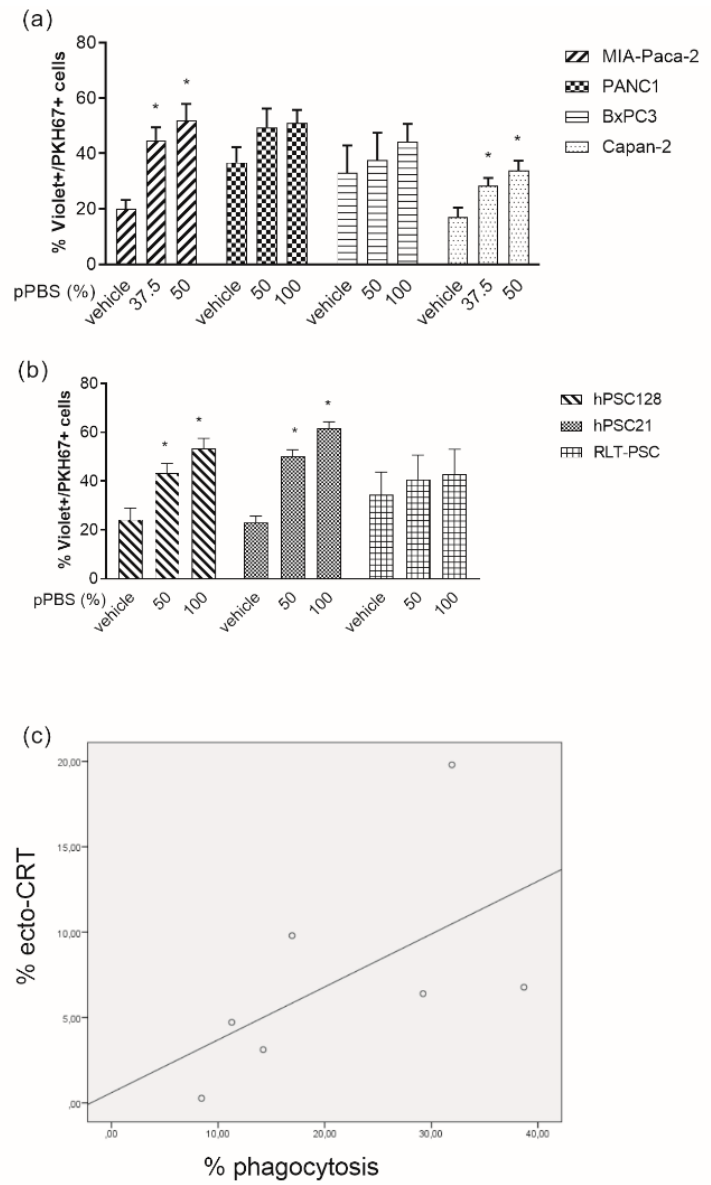
Figure 3. Phagocytosis of pPBS-treated PCCs and PSCs by immature dendritic cells (DCs). ( a ) Percentage of phagocytosis of four different PCC lines (MIA-Paca-2, PANC-1, BxPC3, Capan-2) and (b ) three different PSC lines (hPSC128, hPSC21, RLT-PSC), with increasing dosage of pPBS treatment. Phagocytosis of PKH67+ tumor cells by violet-labeled DC is expressed as the %PKH67+violet+ cells within the violet+ DC population. ( c ) Correlation between exposure of ecto-CRT and phagocytotic capacity of DCs in the seven cell lines (R = 0.786, p = 0.036). Graphs represent mean ± SEM of ≥ 3 independent experiments. * p < 0.05 significant differences compared with untreated control. 2.4. pPBS Treatment of PCC Increases Maturation of DCs without Affecting Their Viability